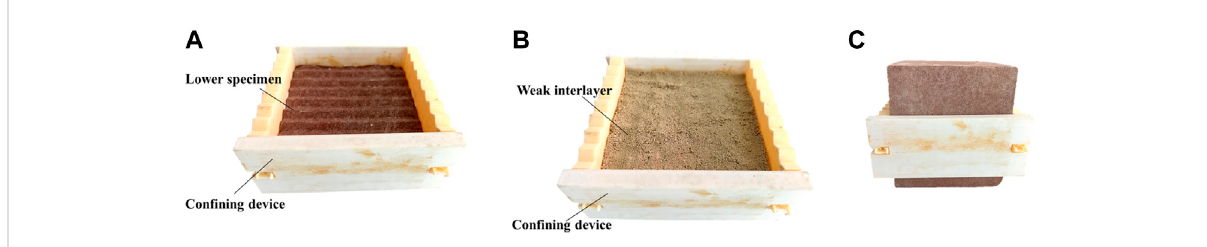
FIGURE 4 Process of sample preparation: (A) Installation of con fi ning device; (B) Add weak interlayer; (C) Sample preparation.